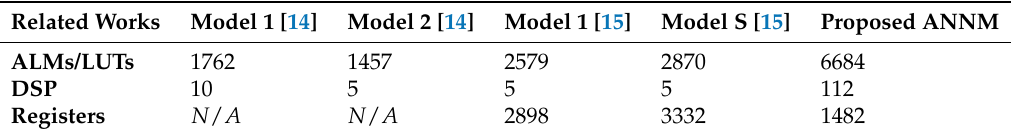
Table 12. Comparison of Hardware Resources usage with related works.